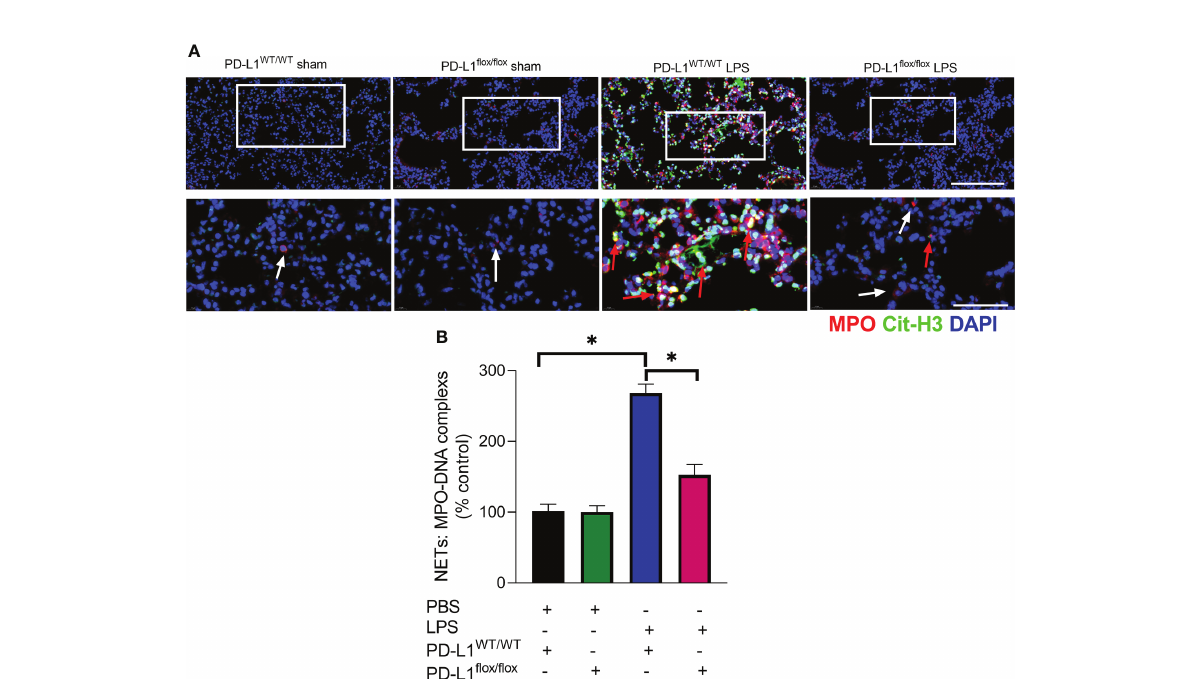
FIGURE 2 Genetic deletion of PD-L1 in neutrophils can reduce NET release in ARDS model. (A, B) PD-L1WT/WT mice and PD-L1 fl ox/ fl ox mice were injected intratracheally with LPS (10mg/kg) for 24h. (A) Representative immuno fl uorescence images of Cit-H3 (green) and MPO (red) staining with blue DAPI nuclear staining in lungs. Neutrophils express MPO (red) and NET forming neutrophils also express Cit-H3 (green). Cyan fl uorescence represents the colocalization of Cit-H3 with DNA. The white arrowheads point to neutrophils not making NETs and the red arrows to neutrophils making NETs. The scale bar indicates 20 m m. Higher magni fi cation images are shown lower row of fi gures – scale bars indicate 10 m m. (B) MPO-DNA complex measured in NETs structures in BALF. The values presented are mean ± SEM (n=3; *P<0.05, one-way analysis of